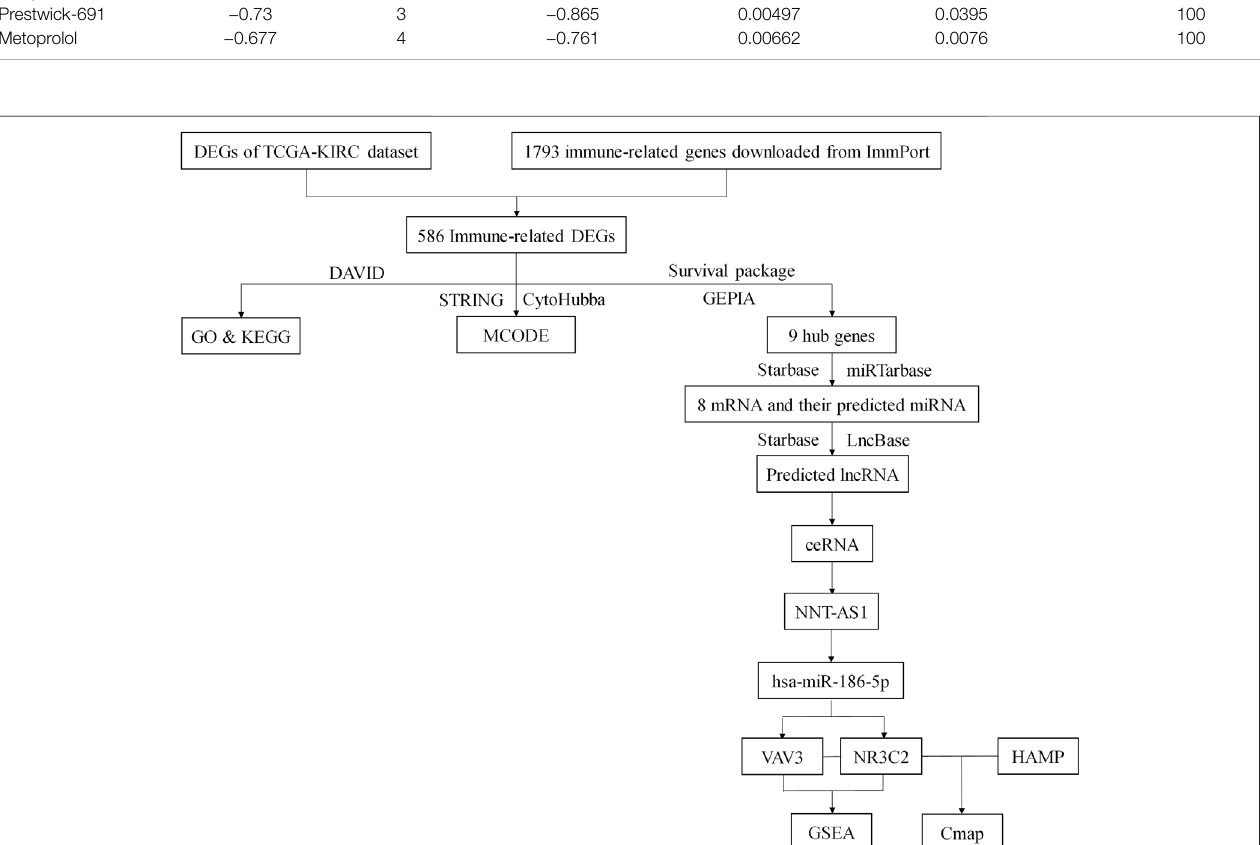
Frontiers in Genetics |